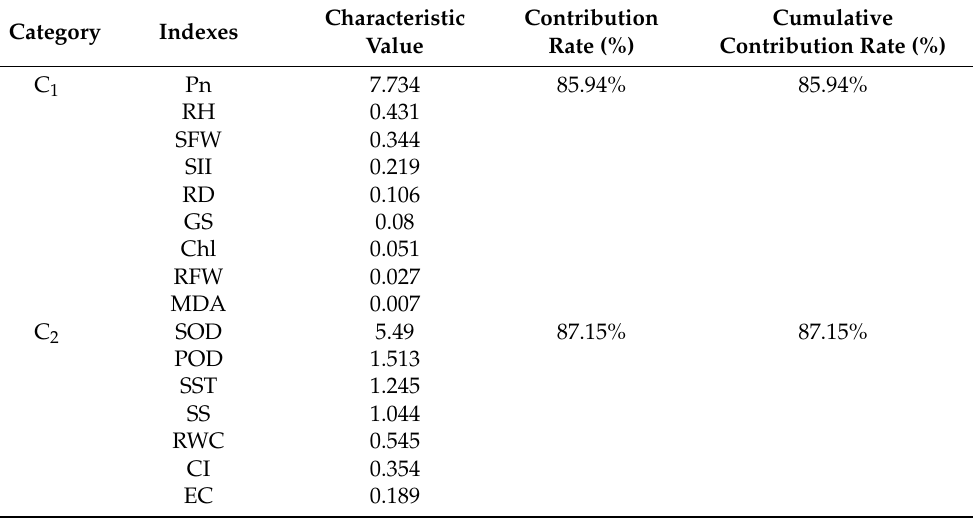
Table 5. Principal component eigenvalues, contribution rate, and cumulative contribution rate of C 1 and C 2